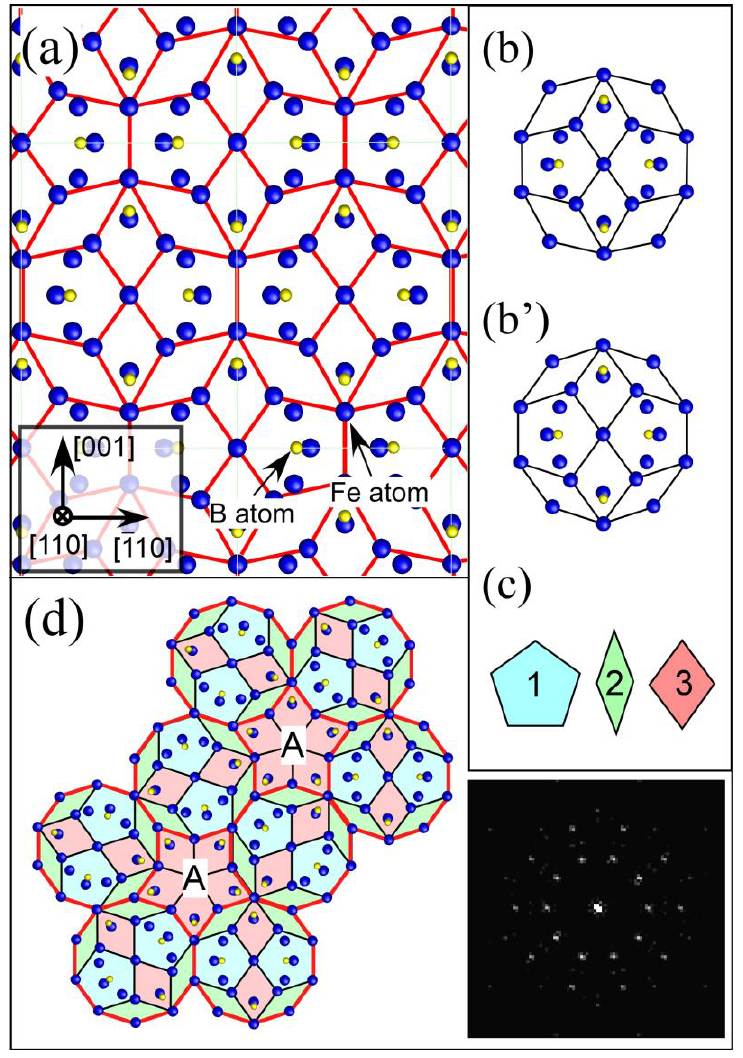
Figure 6. ( a ) [110] projection of an Fe B structure; ( b ) deformed decagonal structural 23 6 unit found in (a); ( c ) decagonal structural unit obtained by transforming the unit of (b), three types of structure tiles as components of the decagonal unit of (c); and ( e ) structure model reproducing the tenfold diffraction pattern shown in Figure 5 ( d ). For the structure model of (e), we first arrange several decagonal structure units (c), and then rotated them by 0, 72, 144, 216, 288 degrees independently. These tiles were subsequently arranged to fill the space by sharing their edges. Though the decagonal structure unit cannot fill the space denoted by A, the space can be filled by using the tile denoted by "3". As a result, three types of tiles shown in (c) can form the structure which reproduces the